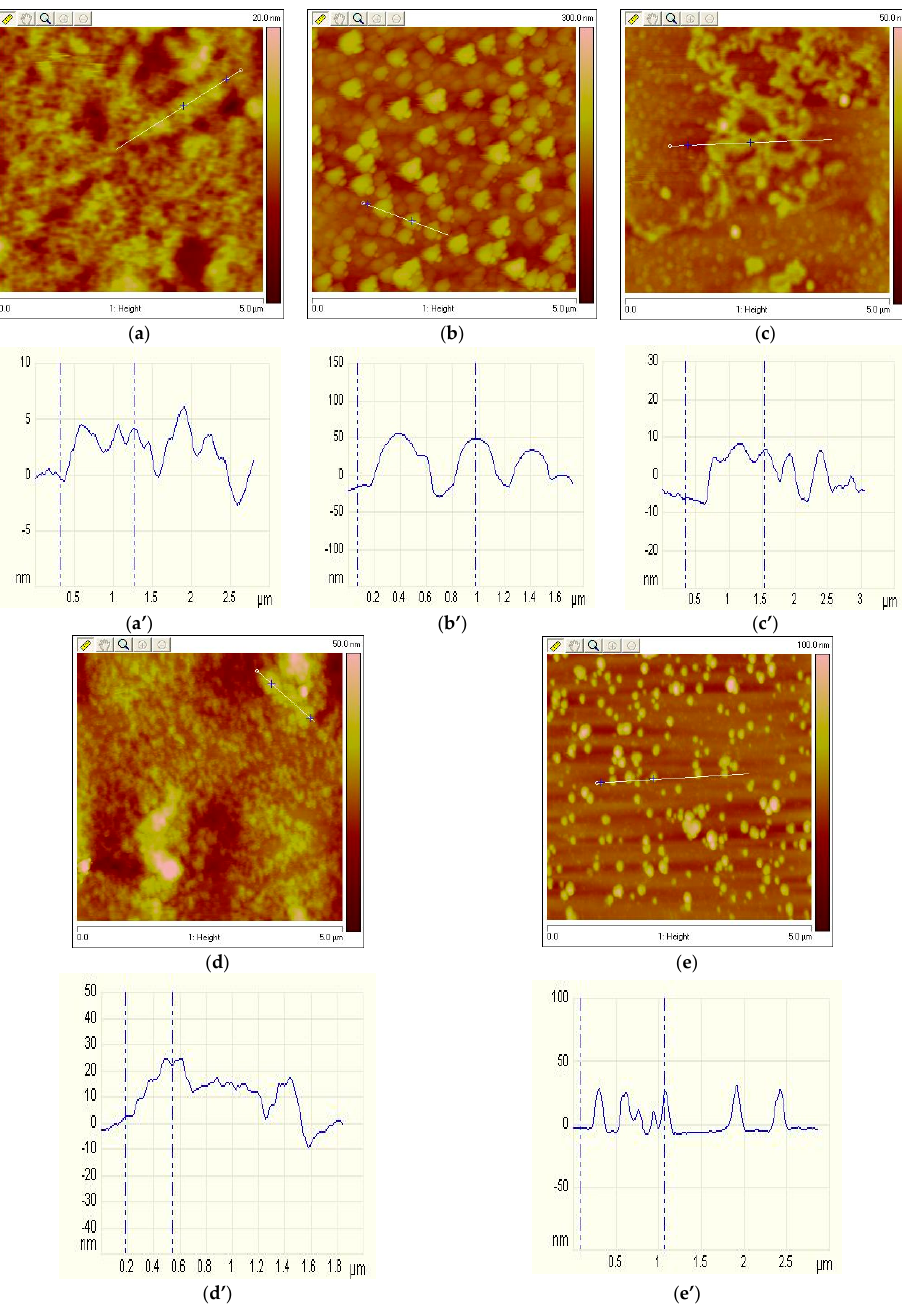
Figure 6. Effect of 120 mg/L MSC on the adsorption characteristic: ( a , a’ ) caustic starch; ( b , b’ ) Fe 3+ starch; ( c , c’ ) Zn 2+ starch; ( d , d’ ) Pb 2+ starch; ( e , e’ ) Mg 2+ starch.